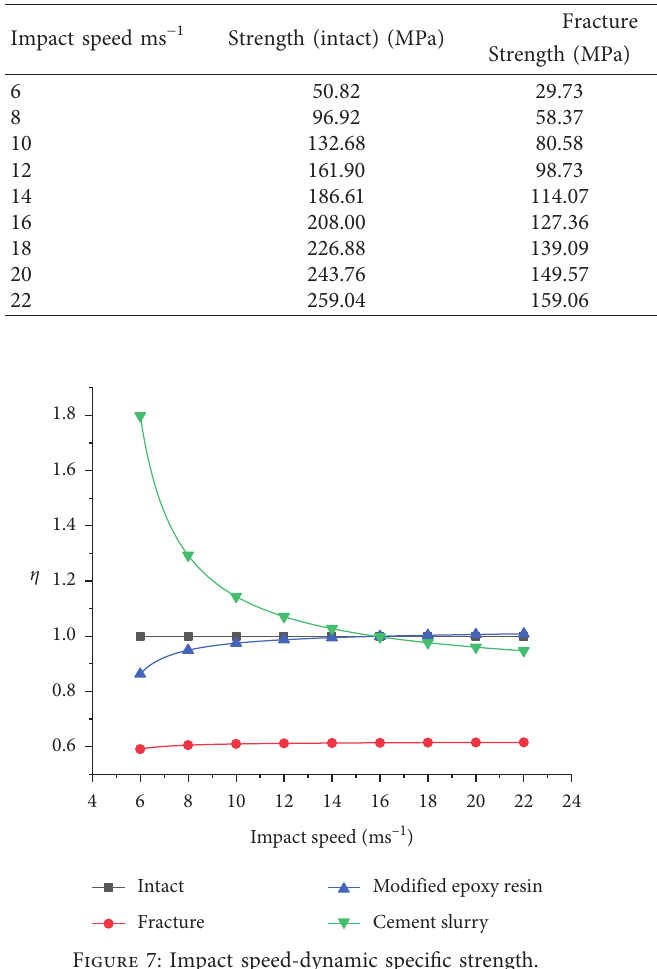
Figure 8: Impact speed-strain rate.